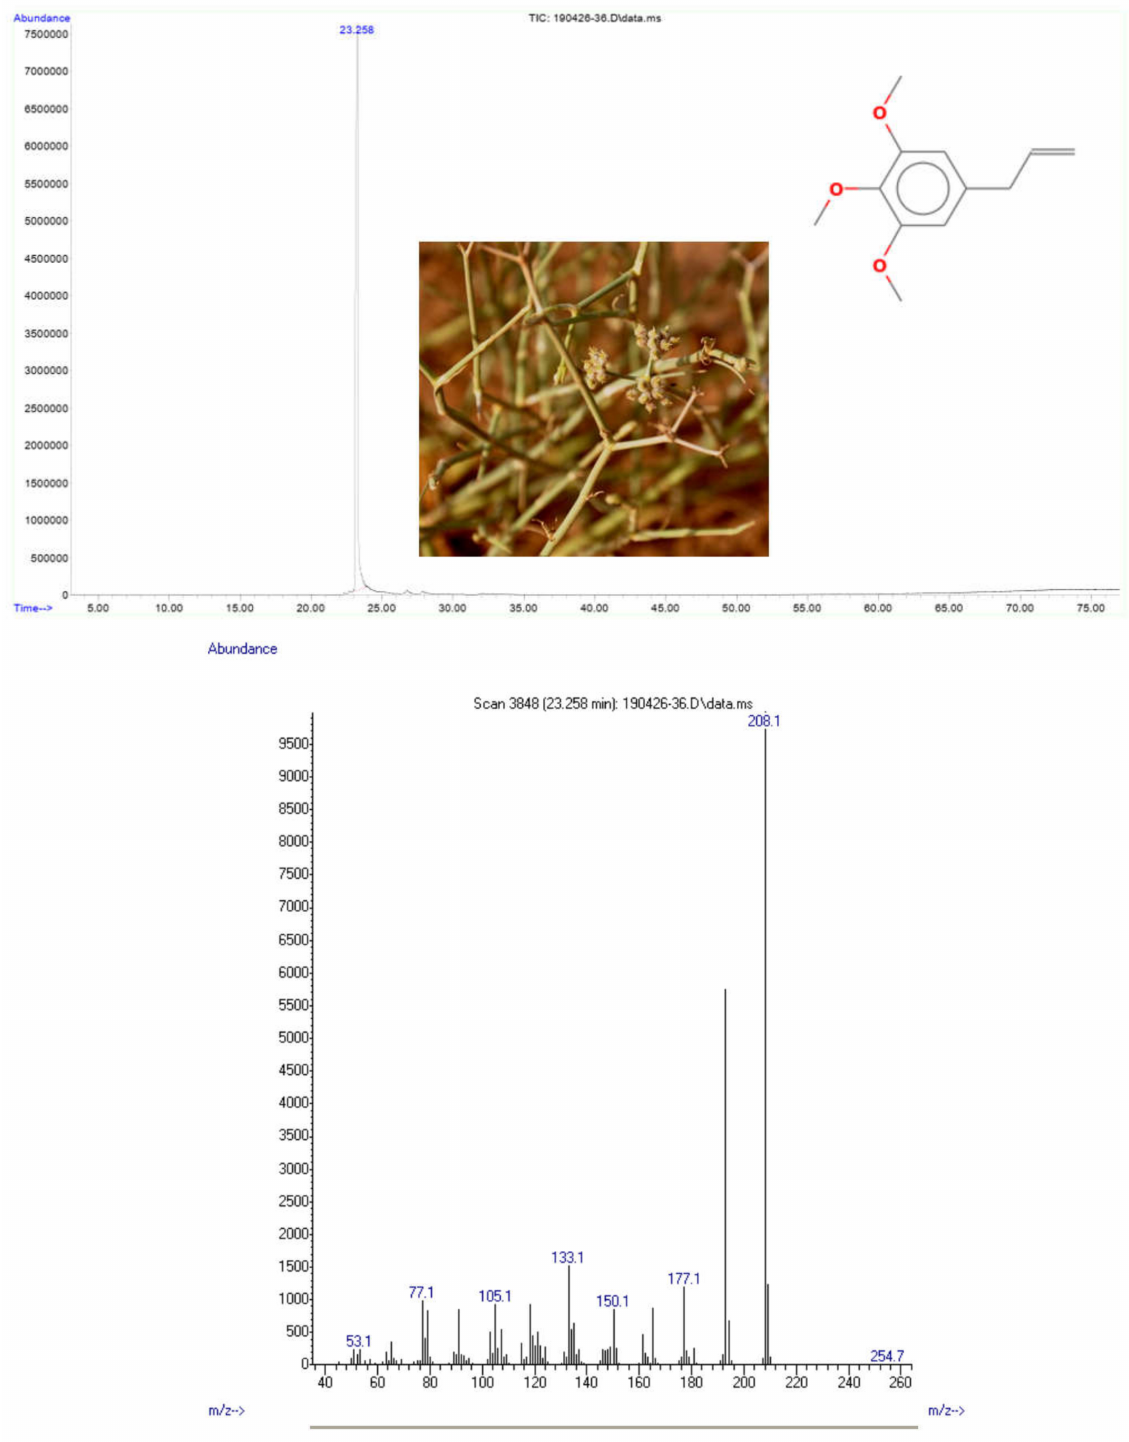
Figure 1. Mass spectra of elemicin as the unique pure compound isolated from flowers’ EOs of D. triradiata